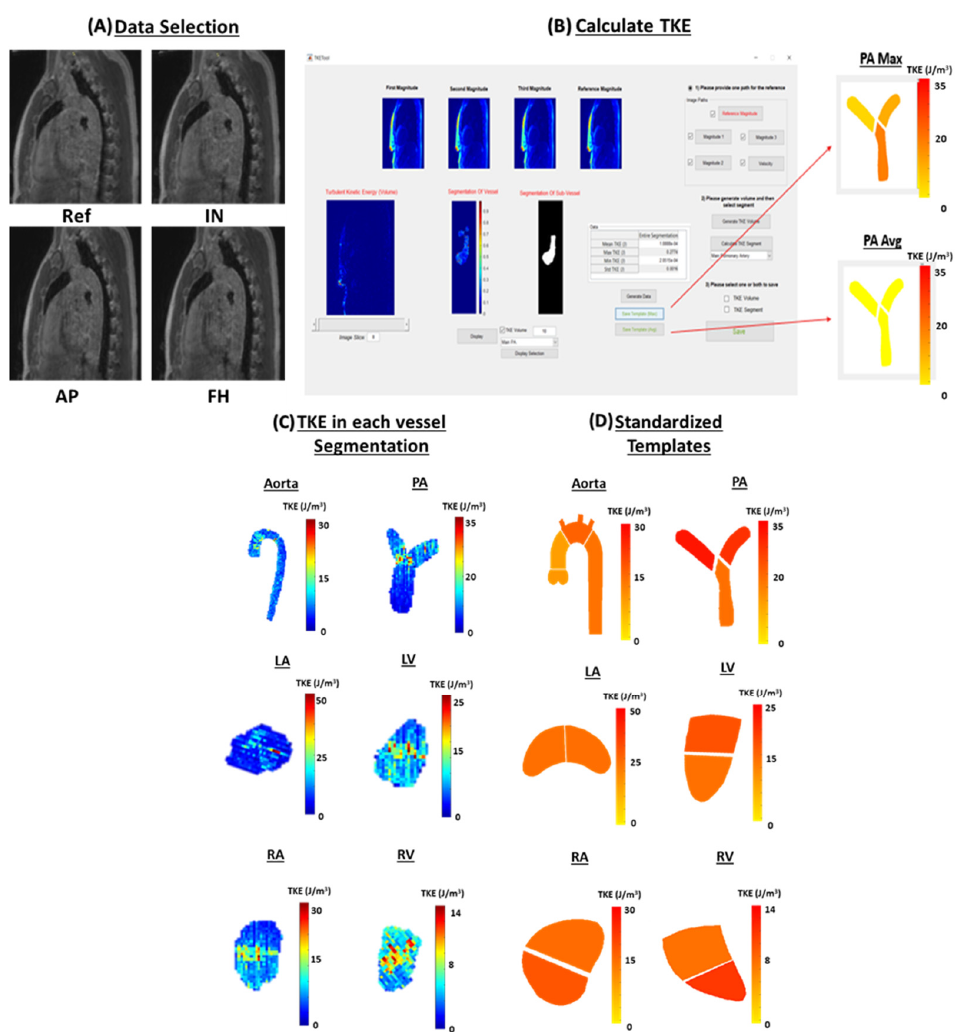
Figure 2. Calculation and analysis of turbulent kinetic energy (TKE). Panel ( A ) shows samples of the magnitude in each direction, including the reference velocity magnitude, in-plane velocity mag- nitude (IN), anterior–posterior velocity magnitude (AP), and foot head velocity magnitude (FH). This is followed by the calculation of TKE using the YYC 4D Flow TKE Tool that was built in-house ( ρ is the fluid density, and 𝜎 (cid:3036) indicates the standard deviation of the component of velocity vector at the i-direction, Panel ( B )). In Panel ( C ), TKE is shown for a healthy control at phase 5 in the Aorta, Pulmonary Artery (PA), Left Atria (LA), Left Ventricle (LV), Right Atria (RA), and Right Ventricle (RV). Similarly, standardized templates were also computed for each vessel (Panel ( D